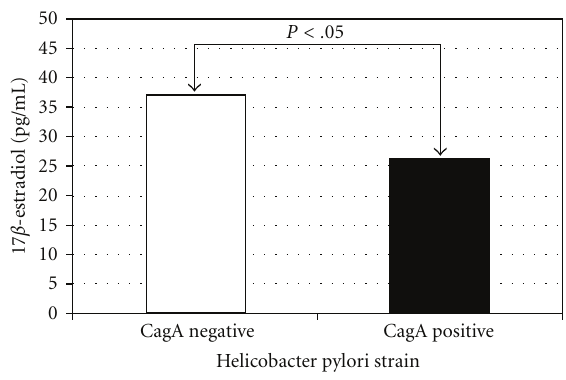
Figure 4: Variations in estrogens levels in elderly men a ff ected by Helicobacter Pylori CagA positive or negative strains (adapted from